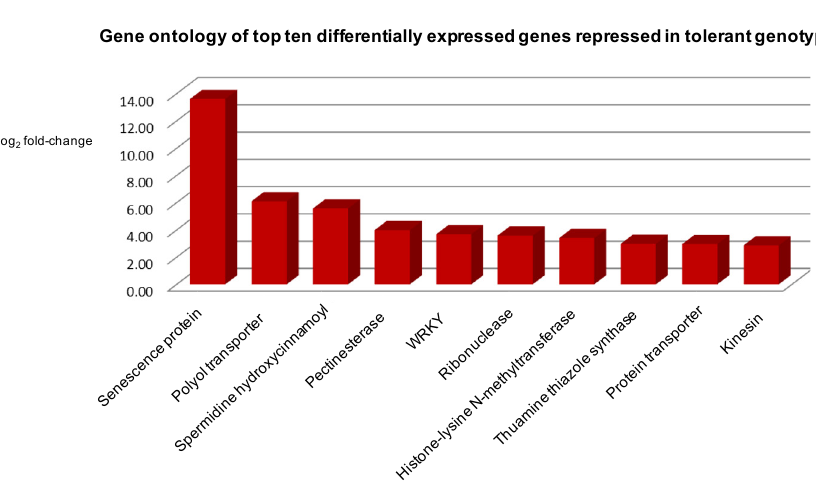
Figure 4. Top ten differentially expressed genes in tolerant genotype response to salt stress.